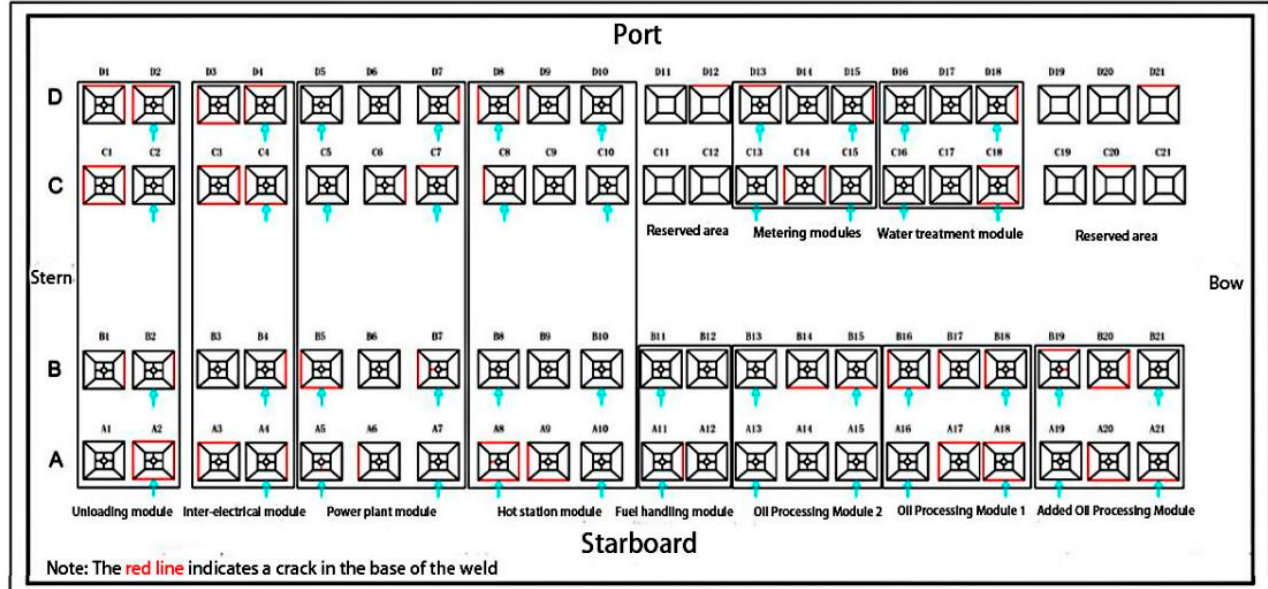
Figure 1. Crack distribution diagram of upper module support pier. (A–D represents the line number).